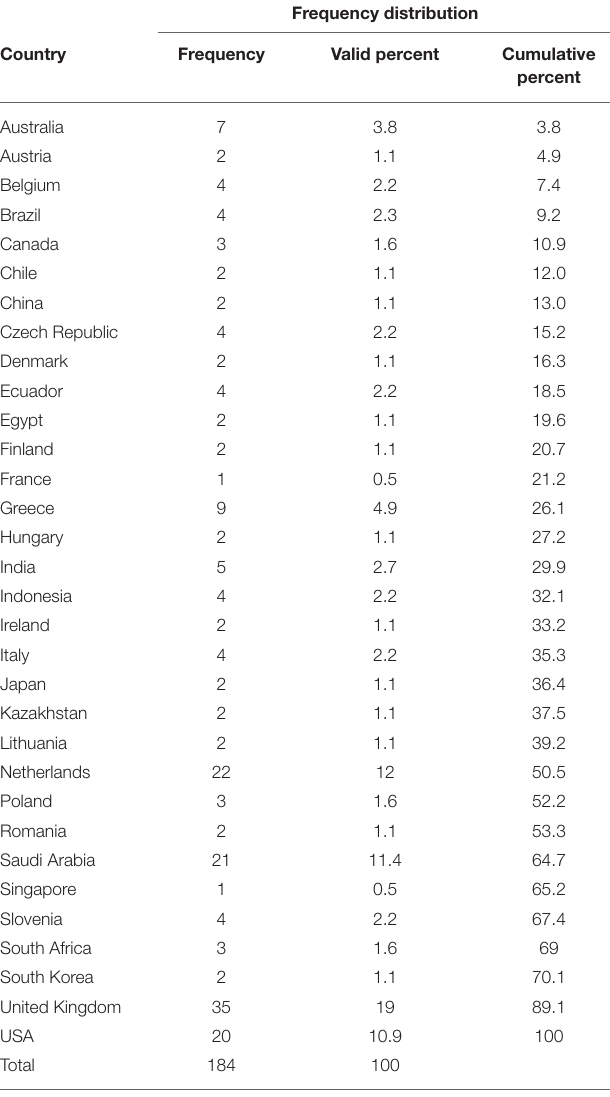
Frequency indicates the number of participants per country. The Valid Percent column shows the percentage that does not include missing cases. Cumulative Percent adds the percentages of each region from the top of the table to the bottom, culminating in